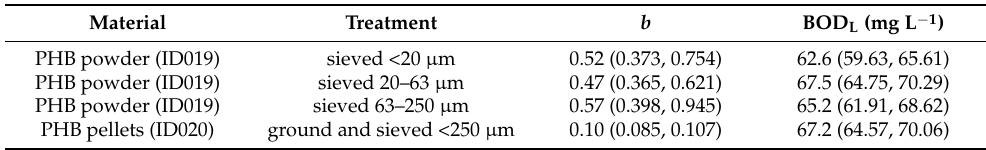
Table A3. Fitting parameters of the BOD curves depicted in Figure A1 to a logistic model (see Equa- tion (1) in Section 2.7). Notice that ground PHB pellets show a significantly slower biodegradation rate ( b ) but the same biodegradability (BOD L ) as the PHB powder stock.